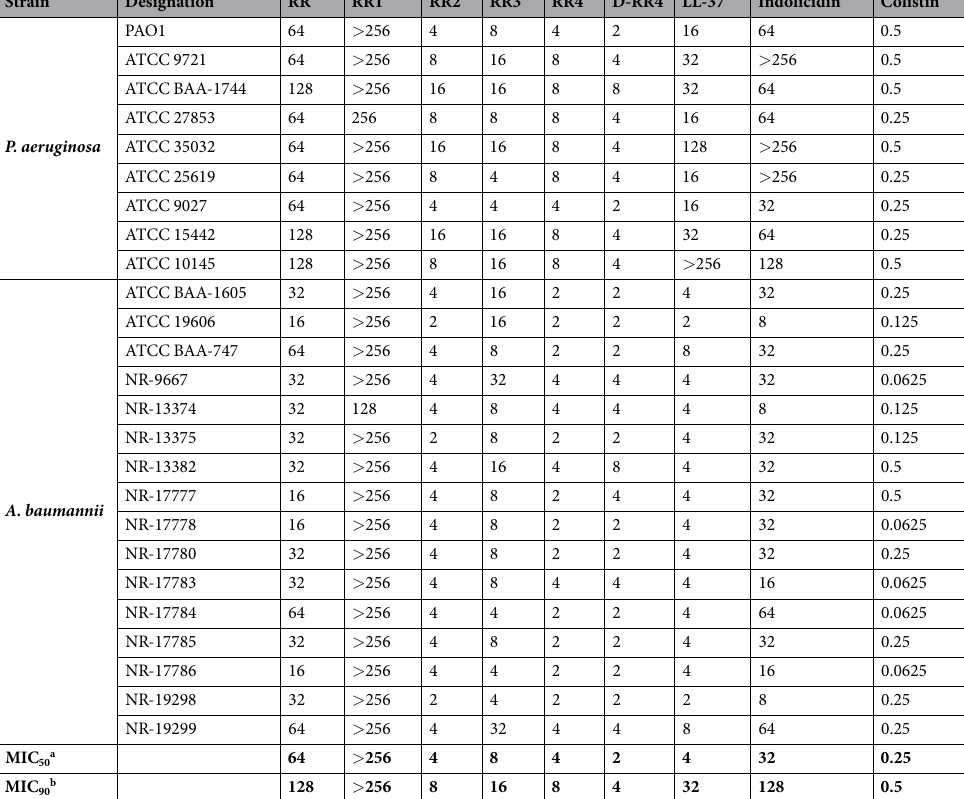
Table 2. Minimum inhibitory concentration (MIC) ( µ M) of peptides against clinical and drug-resistant isolates of P. aeruginosa and A. baumannii . a MIC 50 (The minimum inhibitory concentration that inhibited growth of 50% of all isolates). b MIC 90 (The minimum inhibitory concentration that inhibited growth of 90% of all